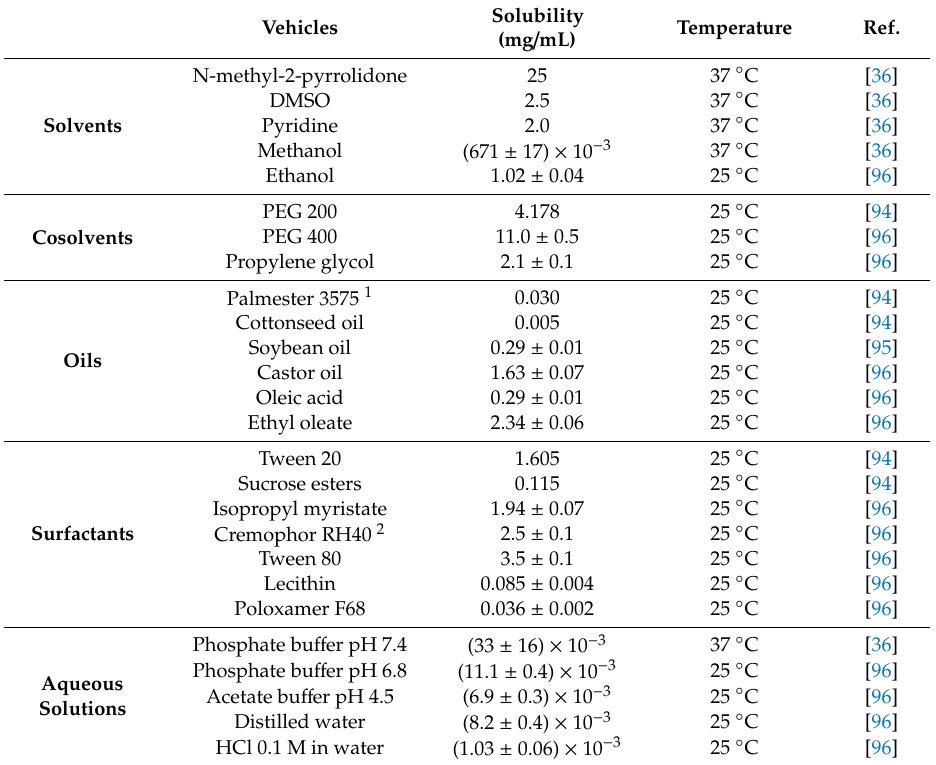
Table 1. Solubility of ellagic acid in various